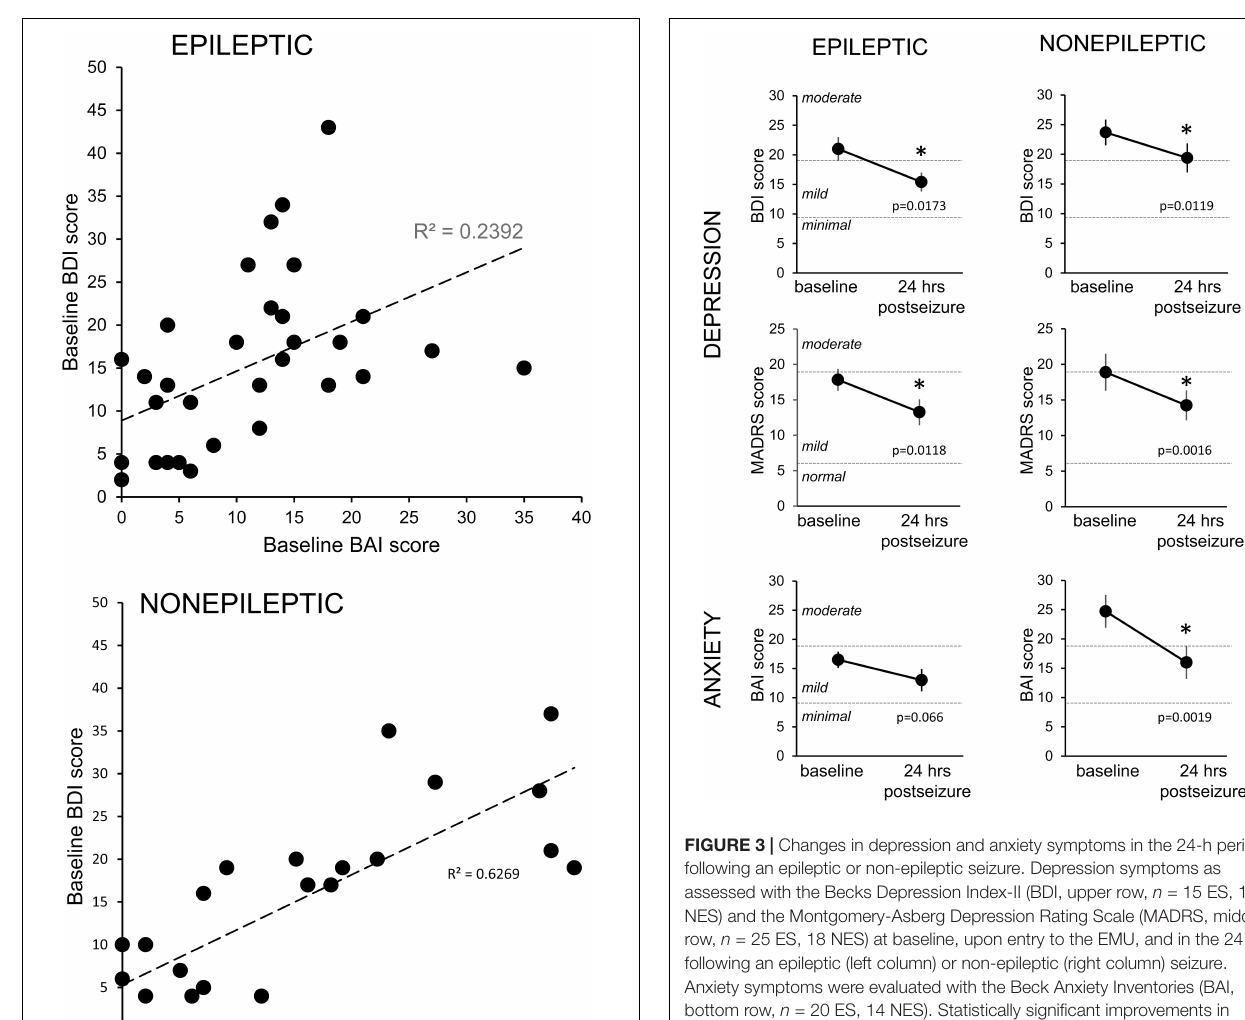
NES patients it was 16.7 ± 7.1% in the BDI, 26.8 ± 6.6% in